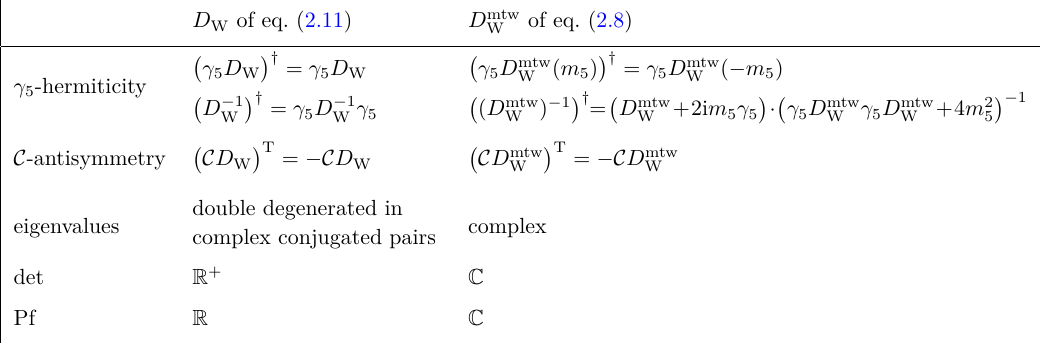
Table 3 . Properties of the untwisted and twisted Wilson Dirac